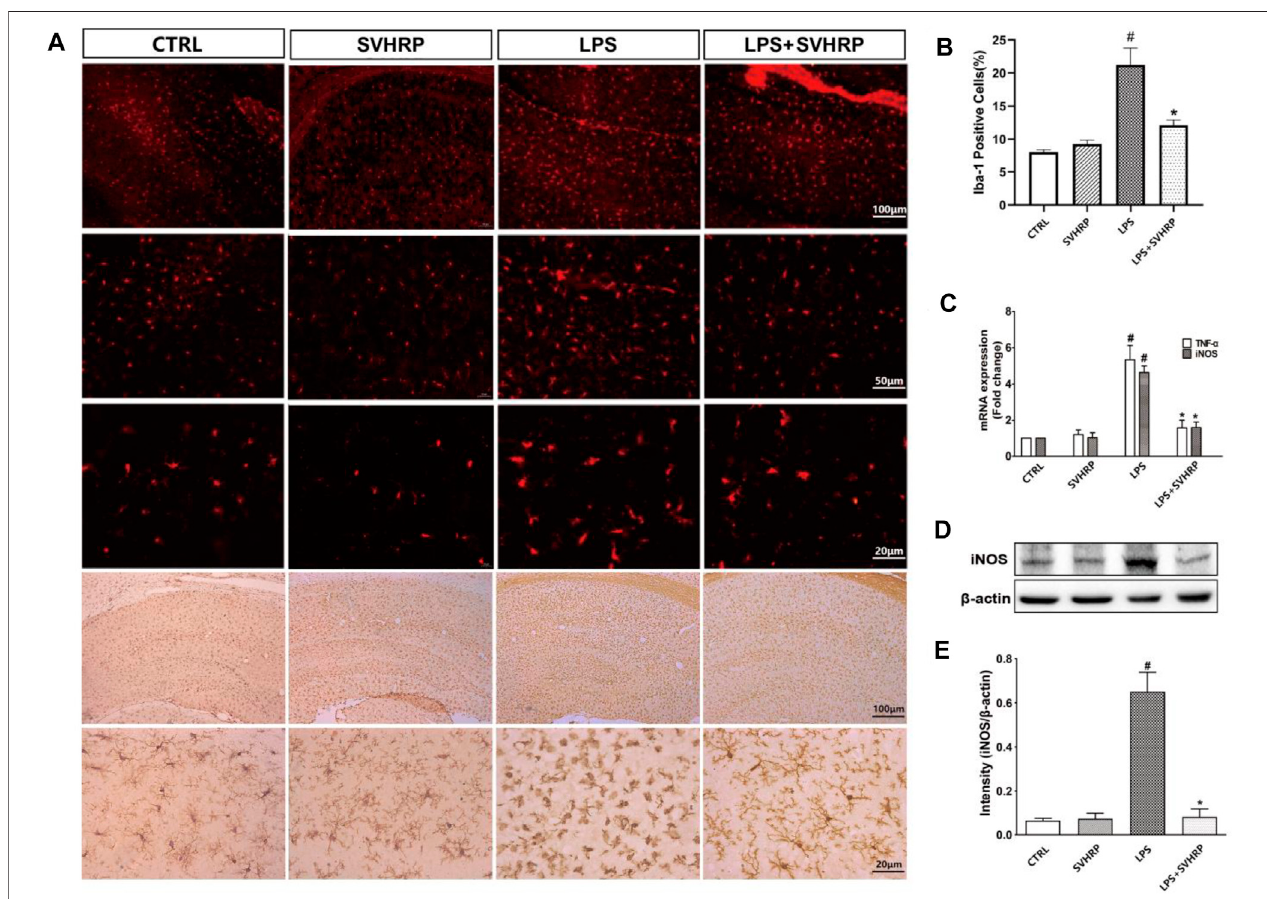
FIGURE1| SVHRPinhibitsin fl ammagen-inducedmicrogliaactivationandin fl ammatoryresponseinhippocampus.MicewereinjectedwithSVHRP(LPS+SVHRP or SVHRP group, 125 µg/5 ml/kg, i.p.) or NS (LPS or CTRL group, 1 ml/kg, i.p.) for 3 days before and 1 day after LPStreatment (5 mg/kg,i.p.) before the mouse brains were harvested for immuno-staining for Iba-1. (A) Representative images of Iba-1 staining (IF staining, upper three panels and IHC staining, lower two panels) in hippocampus were demonstrated. (B) The average percent area of Iba-1 positive staining of four groups was analyzed using the images from IHC staining. (C) mRNA expressions ofTNF- α and iNOS from hippocampus were measured by real-time PCRand calculatedusing 2 − ΔΔ CT method withGAPDHasthe internal reference gene. The expression of iNOS protein from hippocampus was assessed by western blot. (D) Representative blot for iNOS and (E) quanti fi cation of iNOS protein normalizedto β -actin.Thedatawereexpressed asthemeans ± SEM( n ≥ 3foreachgroup). # p < 0.05comparedwithCTRLgroup,* p < 0.05comparedwithLPSgroup.